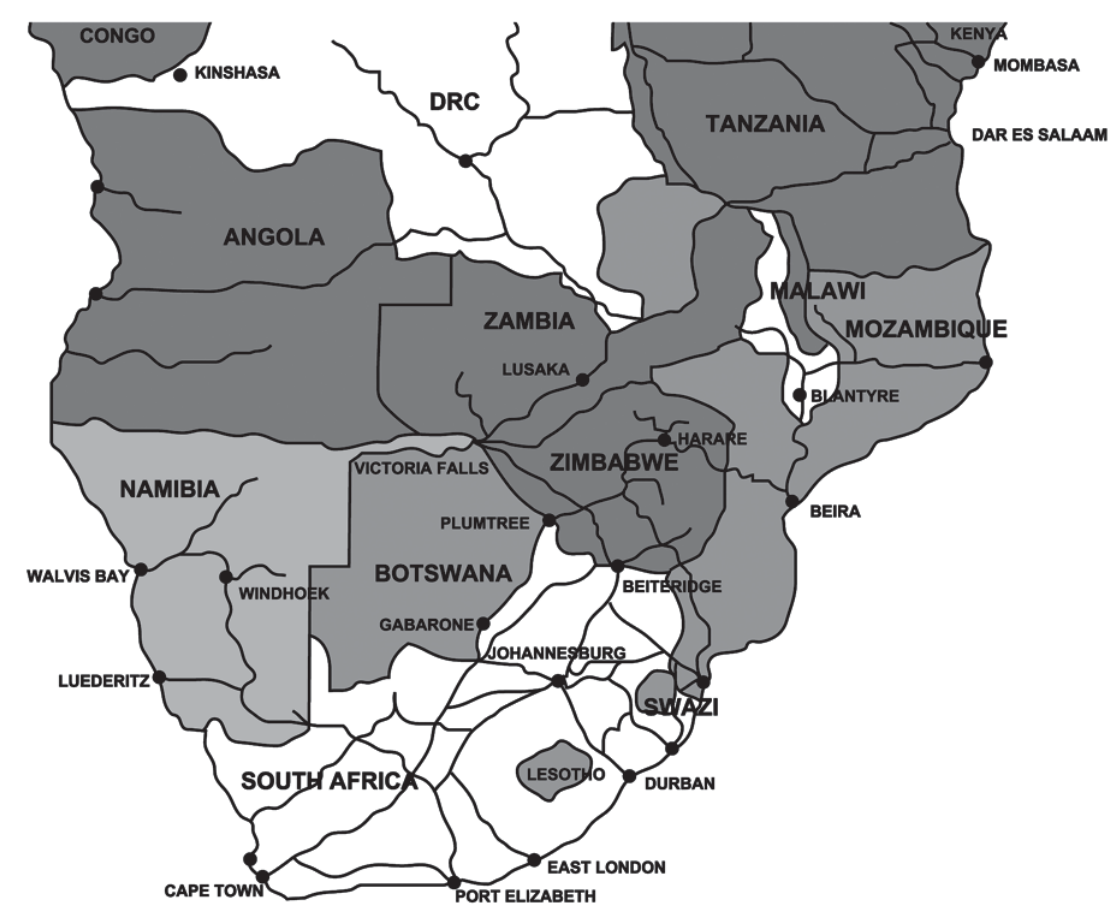
Figure 1: Railway Network of the Southern African Railways Association (Source SARA,